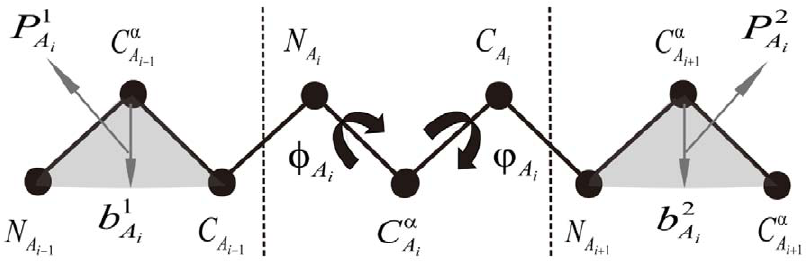
Figure 2. A Schematic Diagram of Spatial Representation and Conformational Constraints of a 3-residue Fragment. The bold letters b 1 and b 2 denote the bisecting vector of C a A i A i denote the vectors in planes defined by three backbone atoms ( N A